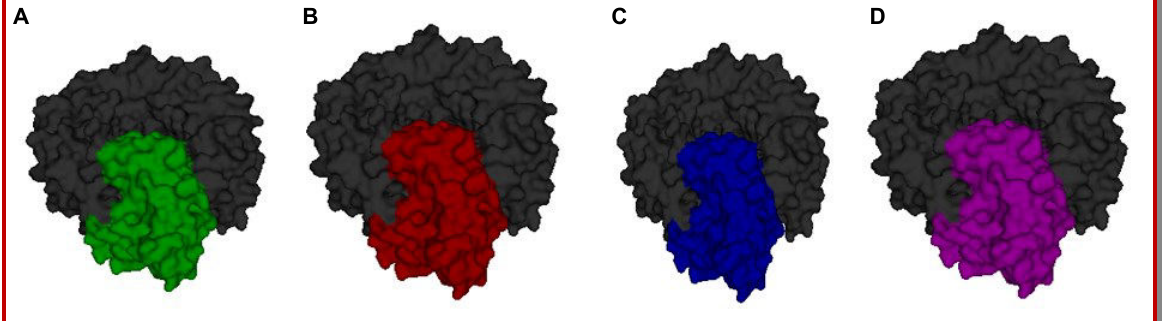
Figure 3: Docked complexes of native and mutant angiogenin with ribonuclease inhibitor (A) Docked complex of Native Angiogenin (green) and Ribonuclease inhibitor (grey) having the Free energy of -1215.59, (B) Docked complex of Q36L (red) and Ribonuclease inhibitor (grey) having the Free energy of -1203.83, (C) Docked complex of C63W (blue) and Ribonuclease inhibitor (grey) having the Free energy of -1202.48, (D) Docked complex of H138R (magenta) and Ribonuclease inhibitor (grey) having the Free energy of - 1198.17